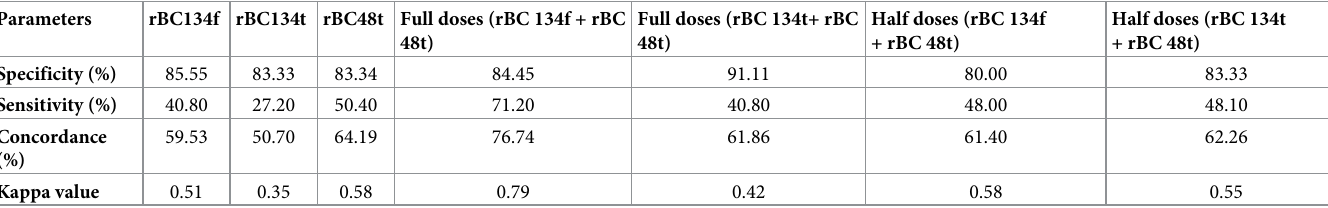
Table 4. The specificity and sensitivity of iELISAs and a comparison of iELISA and IFAT results.